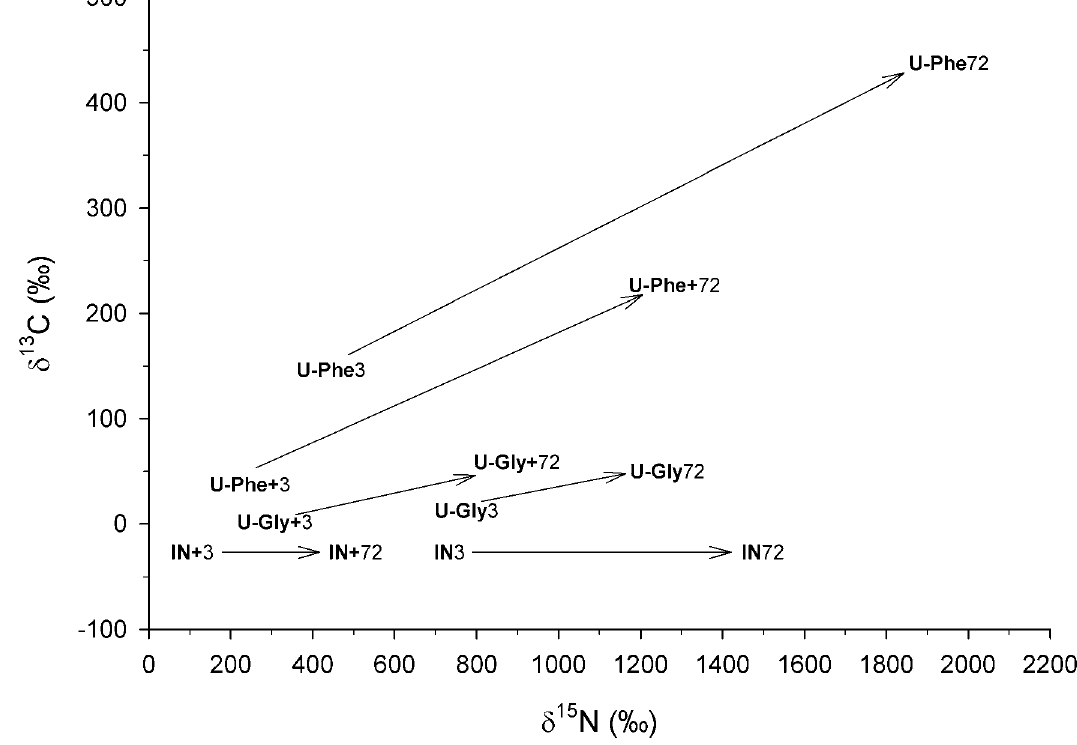
Figure 2. Enrichment of mosquito and midge larvae collected from Sarraceniapurpurea pitchers. The arrows connect points showing enrichment after 3 and 72 hours of plants at Tom Swamp in Massachusetts that were fed 15 N as ammonium nitrate ( 15 NH 415 NO 3 ), uniformly-labeled (U-) 13 C- 15 N-glycine or U- 13 C- 15 N-phenylalanine alone ( IN , U-Gly , and U-Phe , respectively) or in combination ( IN + , Gly + , and Phe + , respectively). Larvae in pitchers fed Phe or Phe + had the highest 13 C and 15 N enrichment after 72 hours.